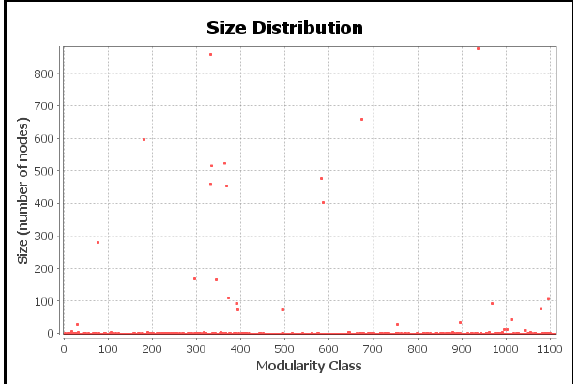
Figure 1. Modularity class values of the analyzed social network